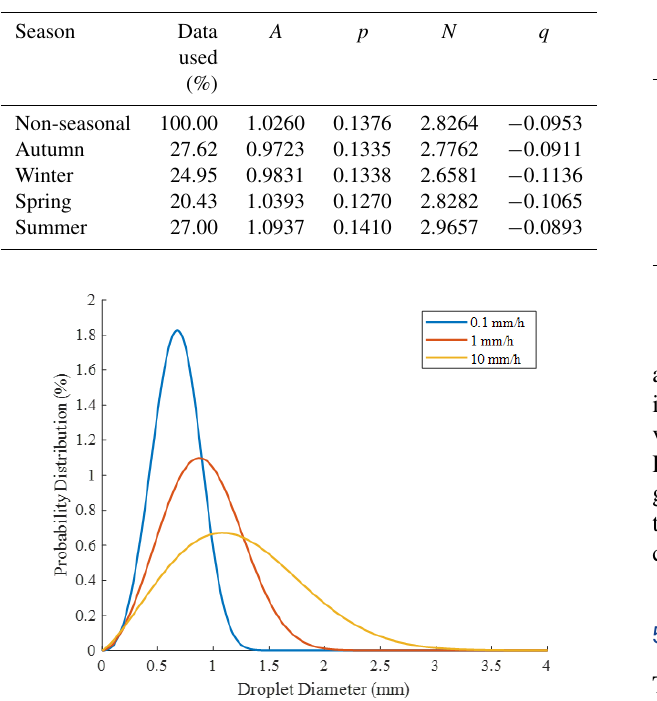
Table 3. Determined constants for the non-seasonal and seasonal offshore DSDs.